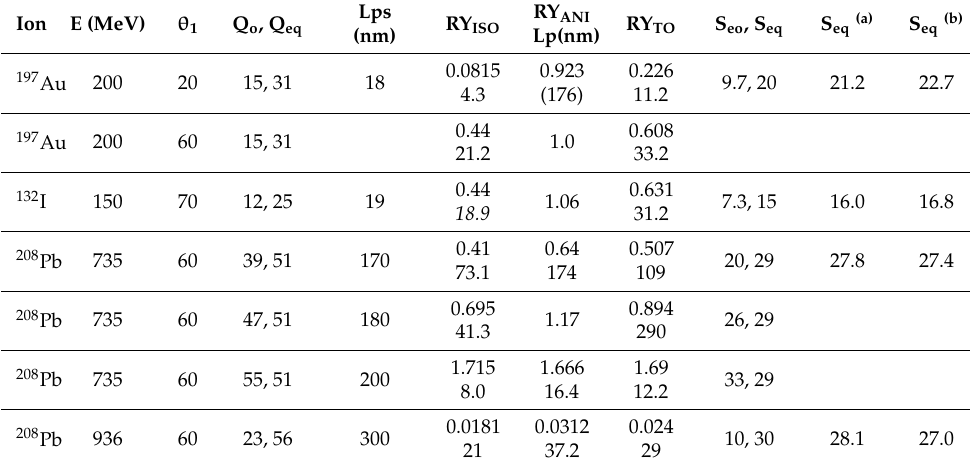
Table 6. Data of LiF sputtering. Ion ( 197 Au, 132 I and 208 Pb), energy (E in MeV), incident angle ( θ 1 ◦ ) measured from the surface normal, incident charge (Q o ), equilibrium–charge (Q eq ), equilibration length (Lps, reaching 90% of the electronic stopping power at the equilibrium–charge), ratios (RY) of the sputtering yield under the non-equilibrium-charge incidence over that the equilibrium-charge incidence for isotropic (RY ISO ), anisotropic (RY ANI ) components and total (RY TO ), electronic stopping power (S e in keV/nm) with the charge of Q o (S eo = S e (Q o )) and Q eq (S eq = S e (Q eq )), from [36]. S eq by TRIM1997 (a) and SRIM 2013 (b) are given for comparison. The length (Lp, underlined) such that the experimental RY equals to the calculated RY is given below RY. Li density in LiF is taken to be 6.13 × 10 22 cm − 3 (2.64 gcm − 3